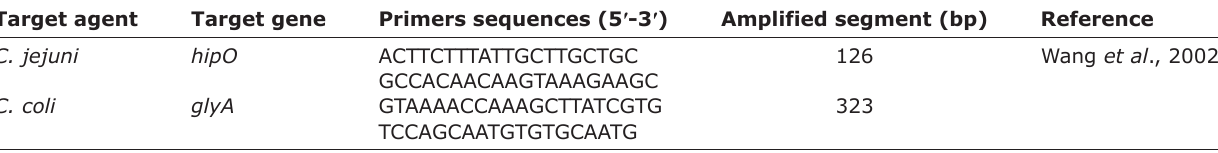
Table-1: Sequences of the oligonucleotide